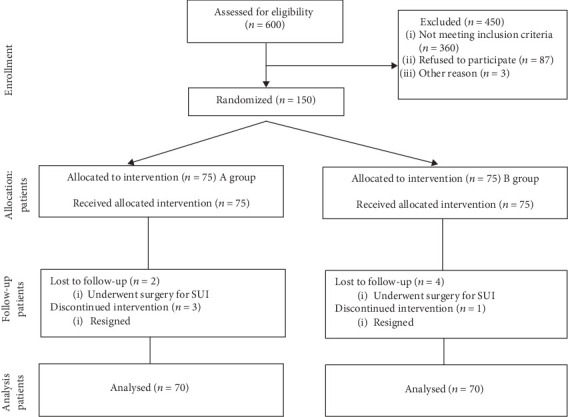
CONSORT diagram of the study [11]